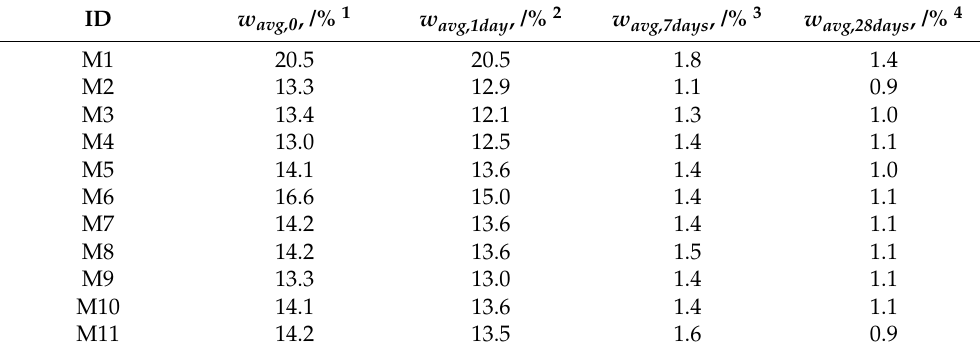
Table 4. Moisture content of the